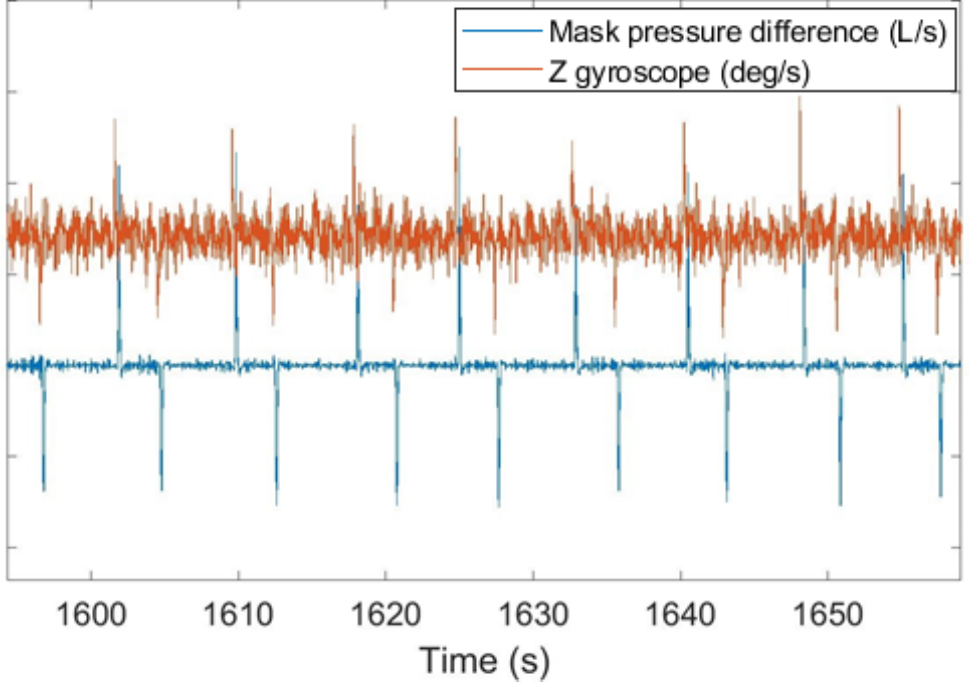
Figure 5. An example of how the change in pressure during variable positive airway pressure (blue) causes artifacts in the gyroscope signal